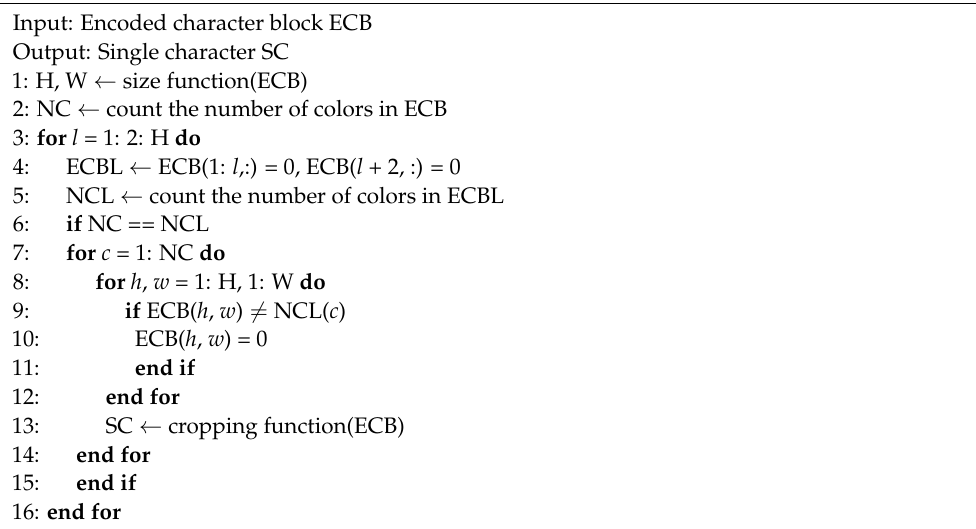
Algorithm 1: Character extraction algorithm based on real location information